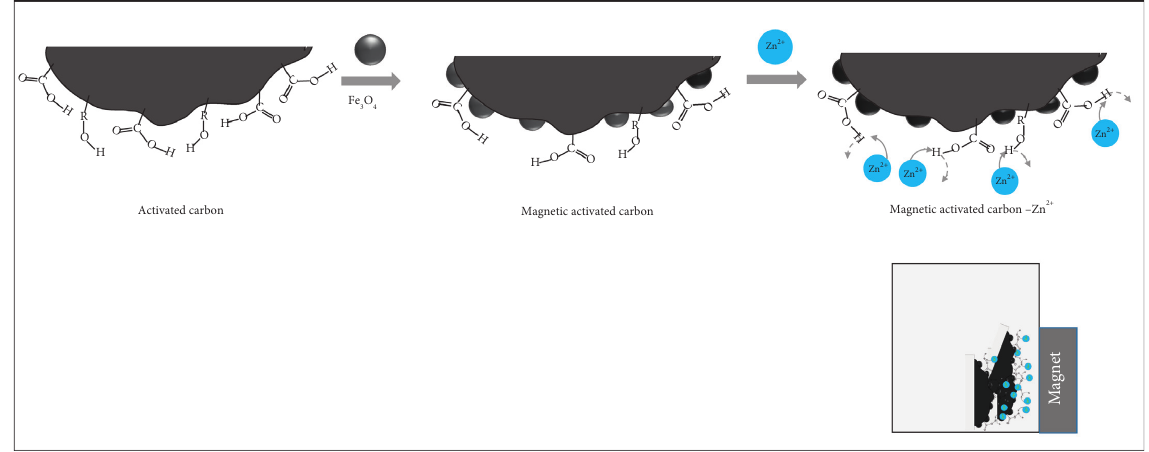
Figure 11: A proposed mechanism of the adsorption